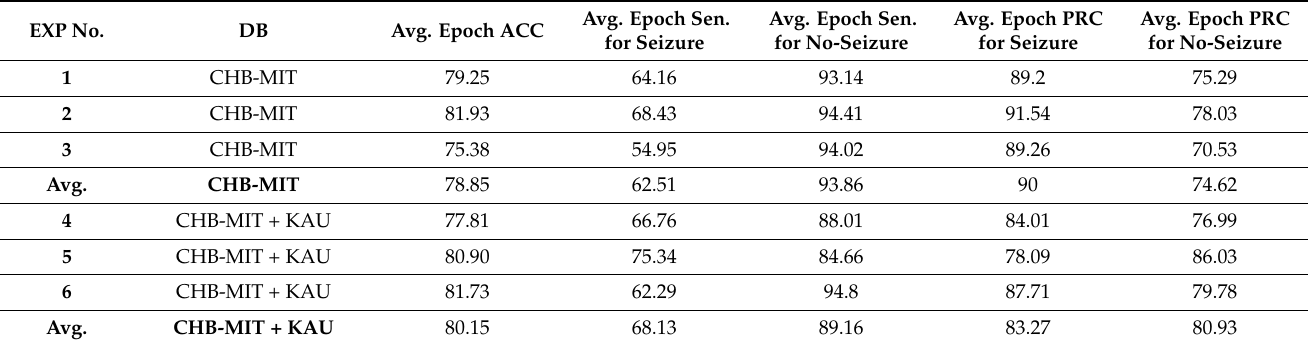
Table 5. The performance of the DL model with and without data